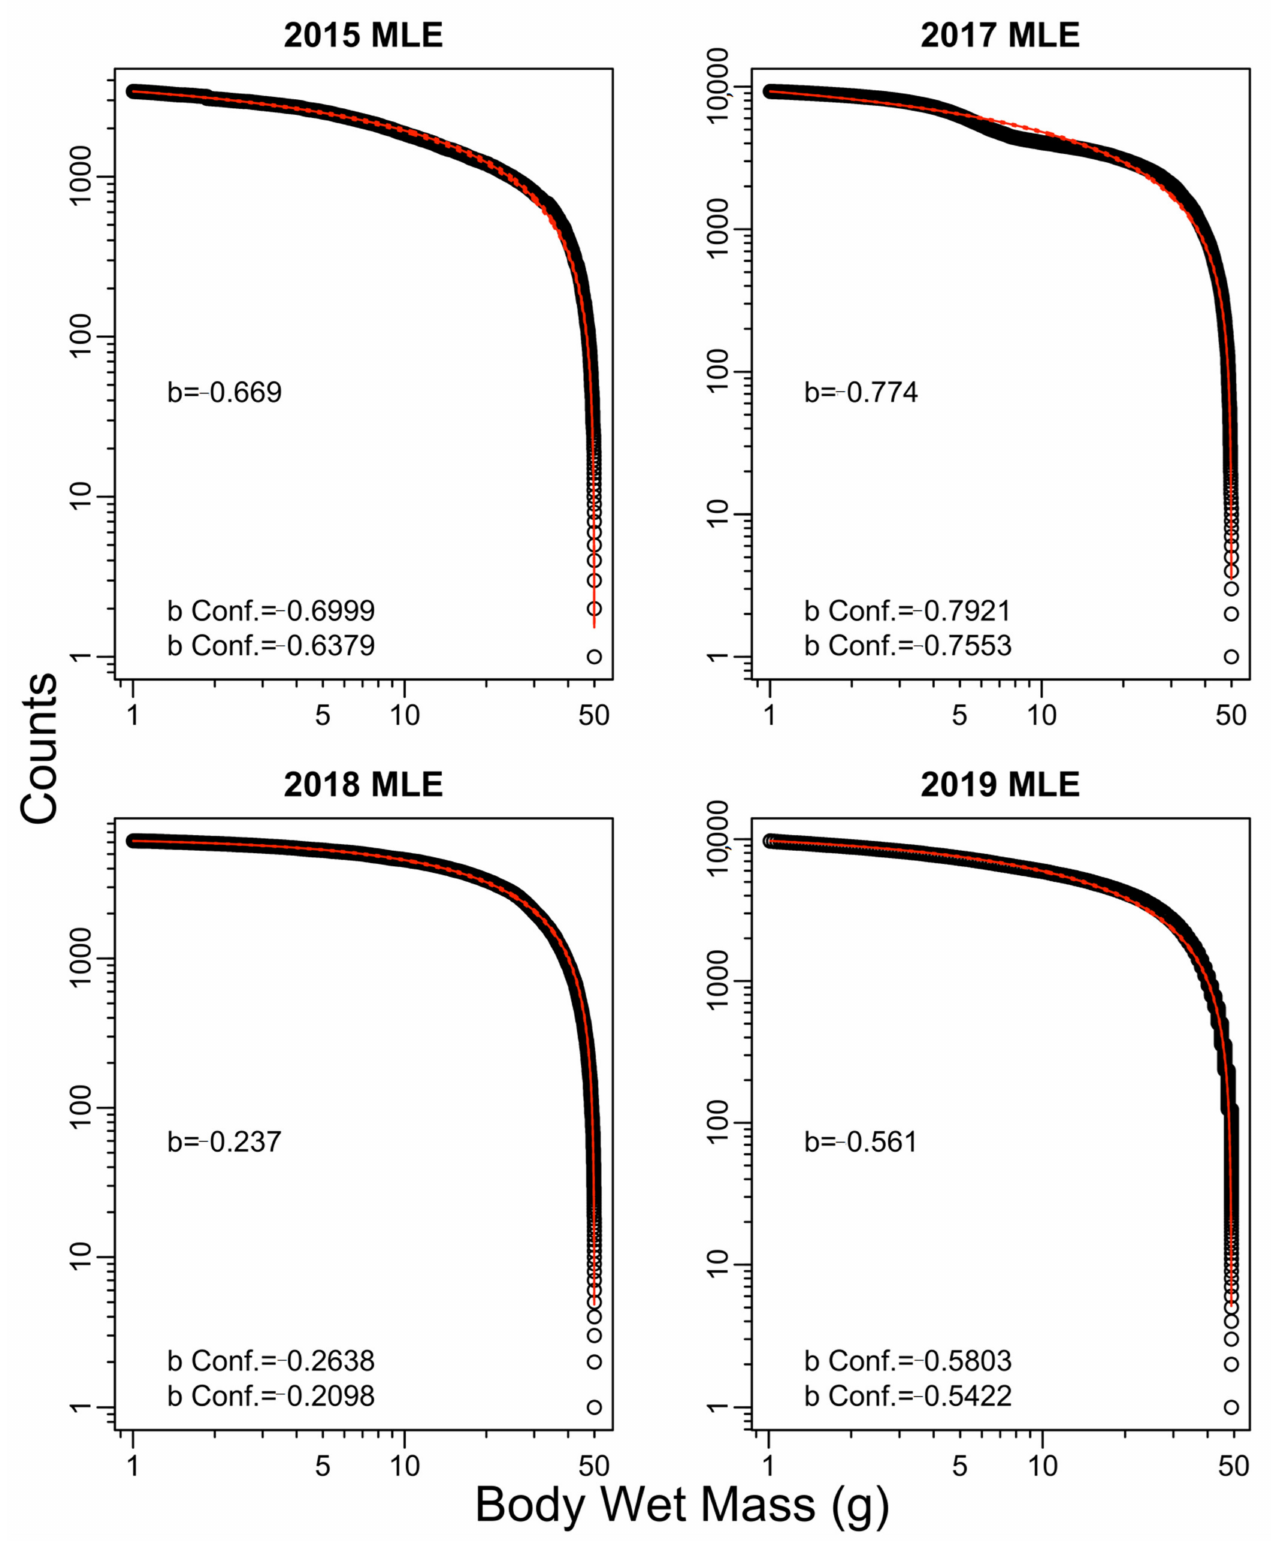
Figure A6. Fish SS with counts and body wet mass (g) fitted using the maximum likelihood estimate of exponent b with the 95% confidence interval of b based on SEDs from hydroacoustic surveys for